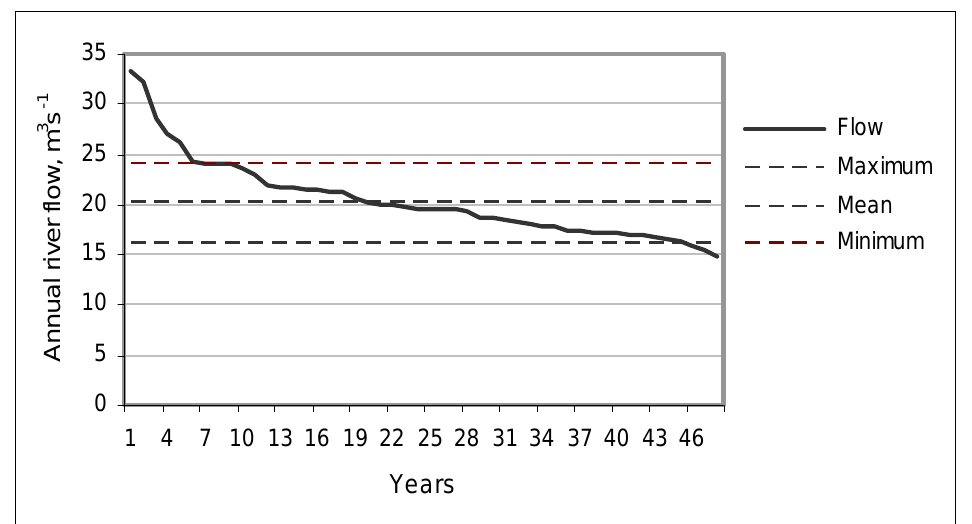
Figure 1. Flow probability curve for the Akbura